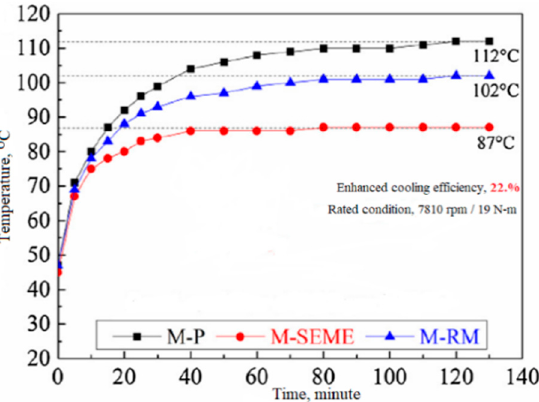
Figure 31. Temperature change with time using heat pipe-based air-cooling under rated conditions [62].